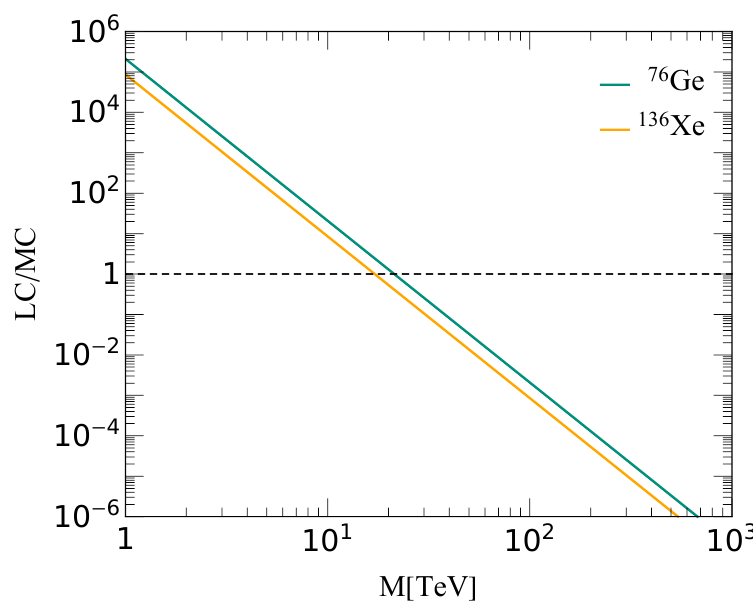
Figure 18 . The ratio of the long-range mechanism to the mass mechanism. In the figure, LC = h i g 4 4 G |A | 2 + 2 G |A | 2 − 4 G |A | |A | denotes the long-range contribution to 0 νββ decay, A 02 E 04 m e 03 m e E and MC= g 4 G |A | 2 is the mass mechanism contribution to 0 νββ decay. The horizontal dash line, A 01 ν representing LC/MC = 1 , indicates that the long-range contribution is equal to that of the mass mechanism. The values of phase space factors and nuclear matrix elements used in this figure are taken from [23, 46].